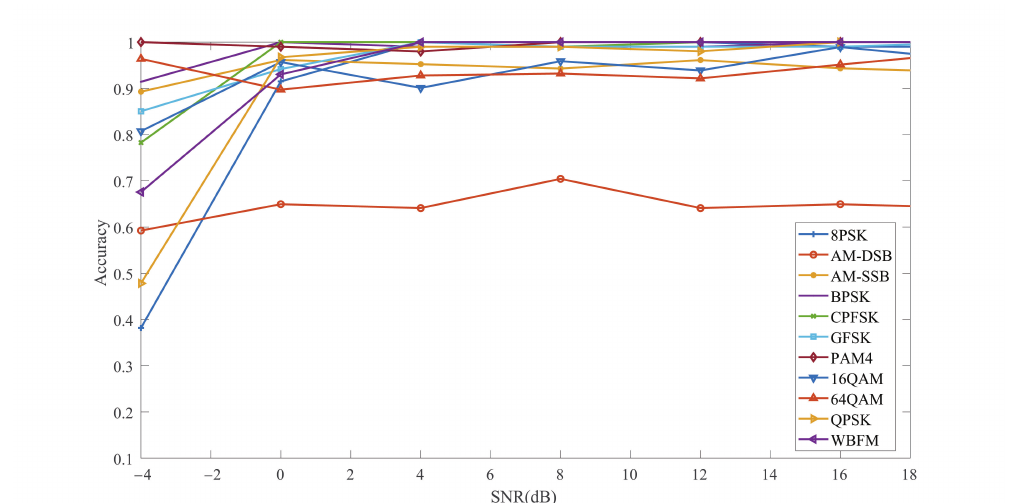
Figure 7. Classification accuracy of different modulation categories.